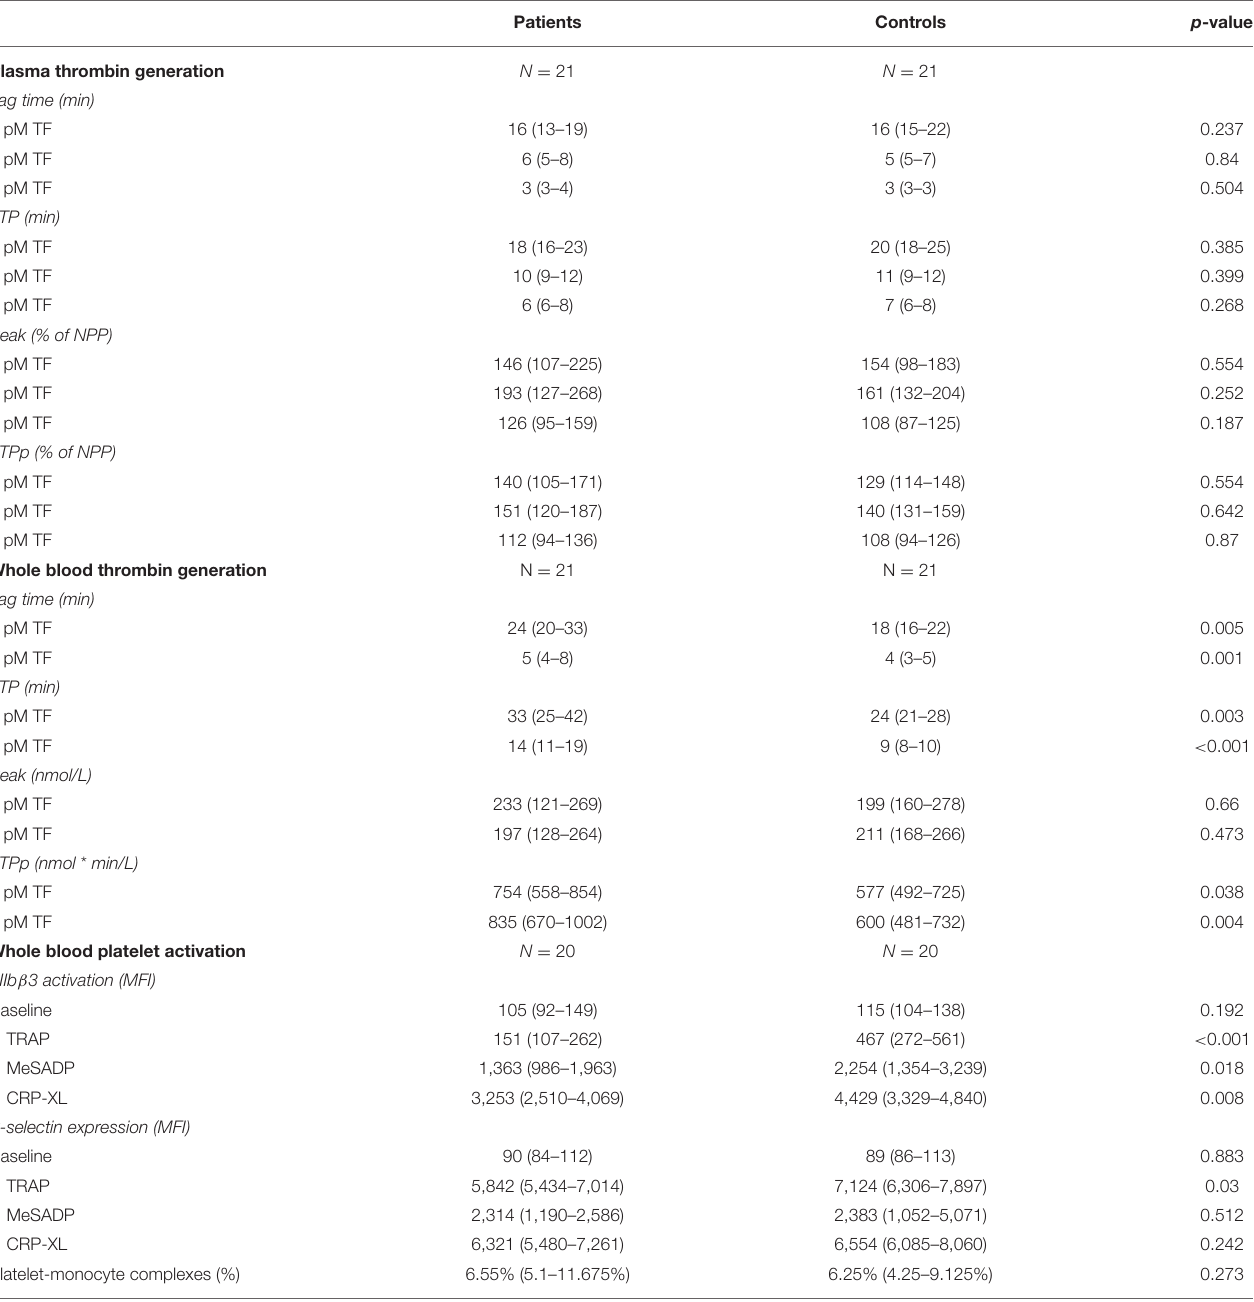
TABLE 2 | Plasma thrombin generation profiles, whole blood generation profiles and whole blood platelet activation profiles of the study subjects. Patients Controls p -value Plasma thrombin